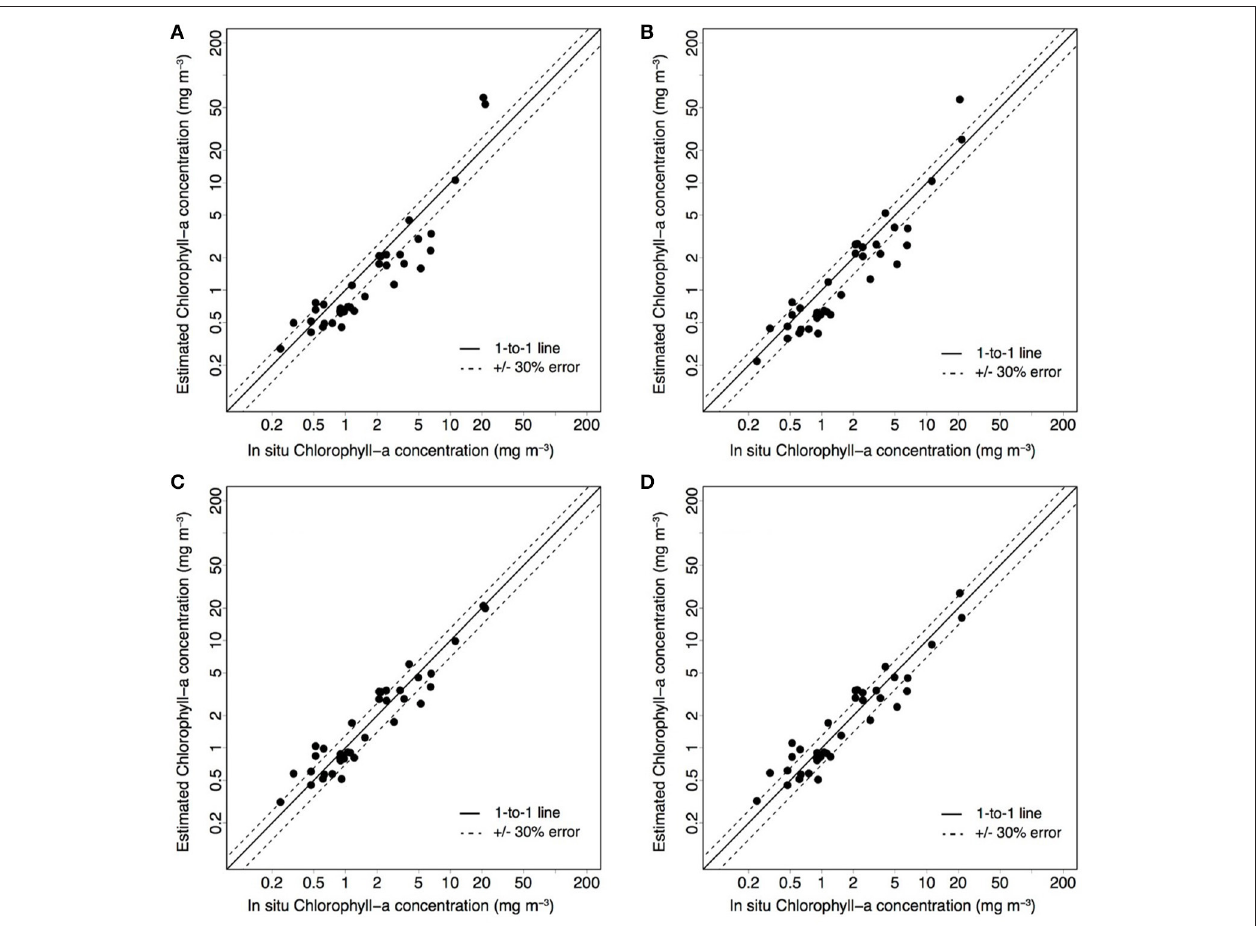
FIGURE 5 | Algorithm performance comparison using in situ data. Comparison of estimated chl-a derived from standard and local algorithms to in situ chl-a on a log-log scale. (A) Standard OC2 chl-a algorithm applied to OLI Rrs . (B) Standard OC3M chl-a algorithm applied to MODIS Rrs . (C) Local OLI-derived chl-a algorithm applied to OLI Rrs . (D) Local MODIS-derived chl-a algorithm applied to MODIS Rrs . Standard algorithms (A,B) tend to overestimate chl-a values in respect to measured values. The local OLI chl-a algorithm (C) estimates chl-a values more accurately than the standard OC2, standard OC3M, and local MODIS algorithms. The solid black line is the 1:1 line. Dashed lines are ± 30% from the 1:1